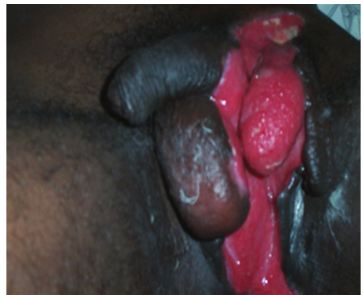
Figure 1: Fournier’s gangrene.